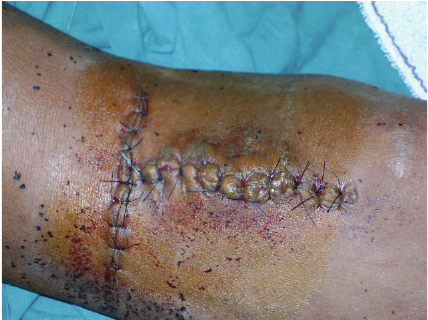
Figure 3: Immediate postoperative appearance of the elbow. The distended veins have disappeared.